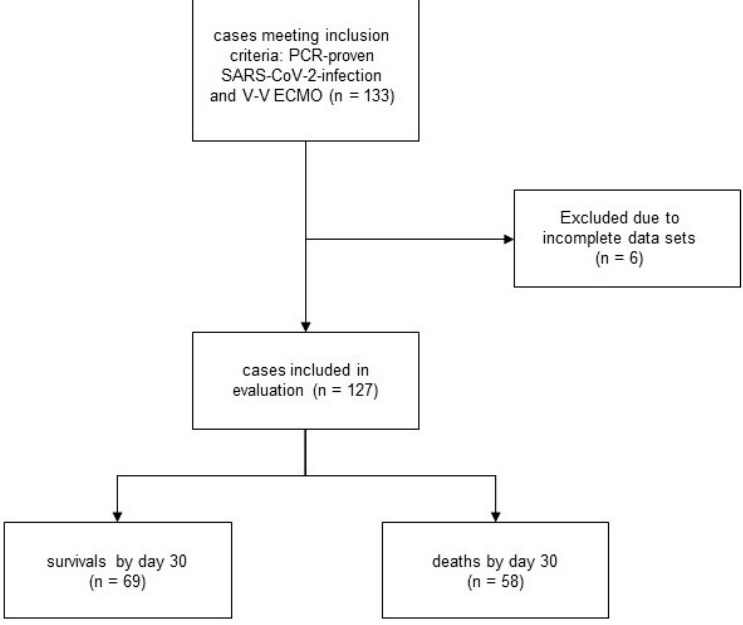
Figure 1. CONSORT flow-chart illustrating patient recruitment, case exclusion, and number of survivors and non-survivors in the study collective. survivors and non-survivors in the study